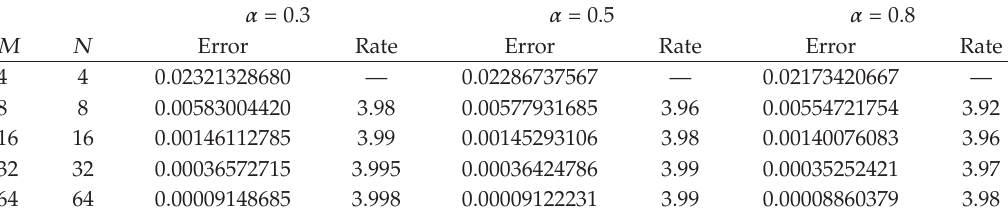
Table 2: The errors for some values of M , N , and α